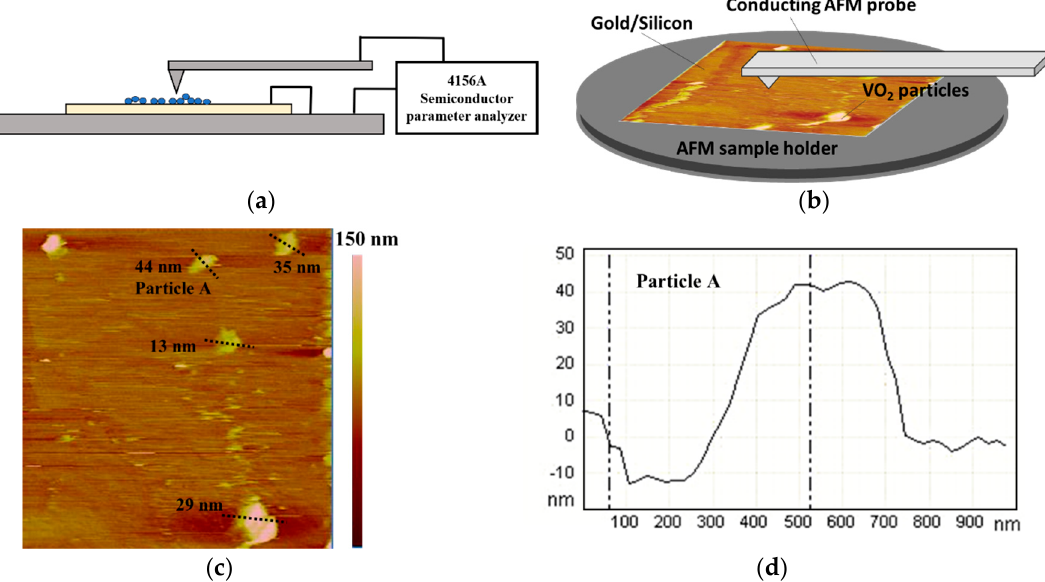
Figure 1. Schematic of AFM setup for scanning NP-VO 2 over gold covered silicon substrate. ( a ) AFM setup modified for imaging as well as current-voltage (I-V) measurement using Pt tip. ( b ) AFM scan showing some of the NP-VO 2 where I-V relationships were calculated. ( c ) Different particle heights ranging from 29 nm–44 nm are seen in the above image. ( d ) Section scan showing the lateral profile of NP-VO 2 with a height of 44nm.